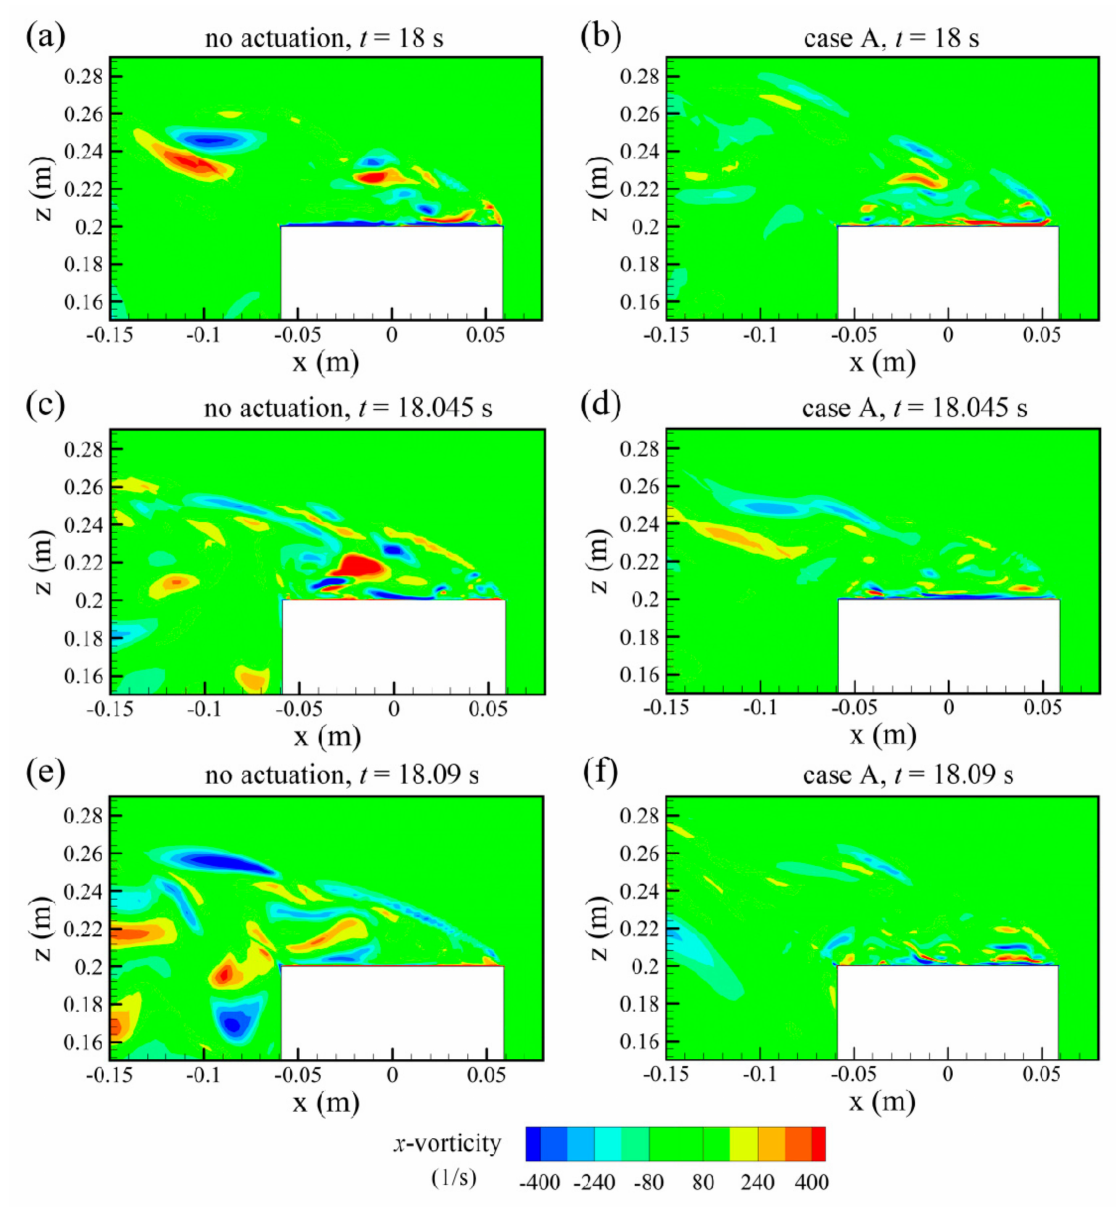
Figure 17. Evolution of instantaneous x -vorticity component with the time t : ( a , b ) t = 18 s; ( c , d ) t = 18.045 s; ( e , f ) t = 18.09 s. The skin friction coe ffi cient C f ( = τ w / 0.5 ρ V h2 ) can be calculated by the wall shear stress τ w